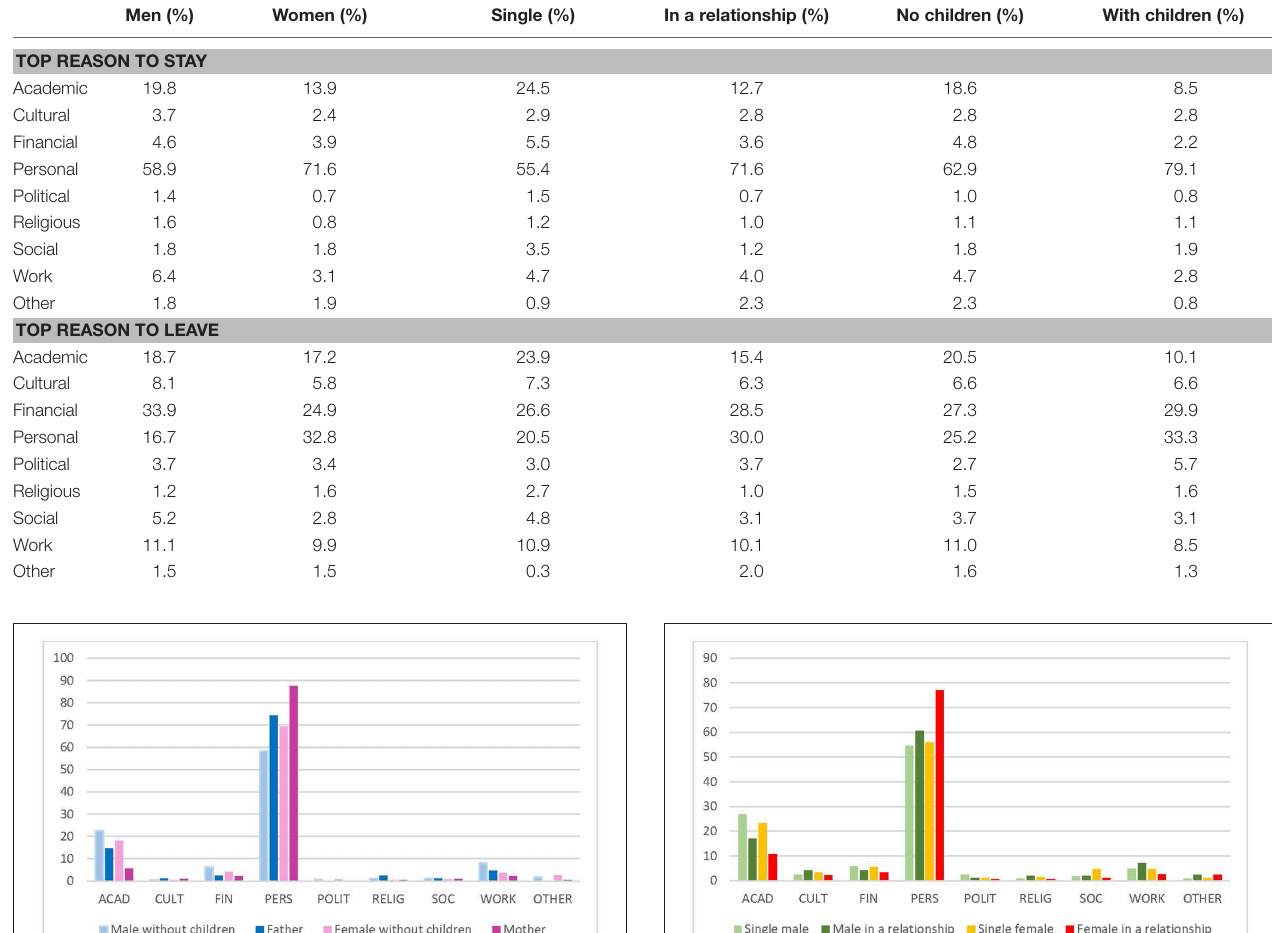
TABLE 5 | Trainees’ top reason to stay and leave their country (by gender, parenthood, relationship). Men (%)